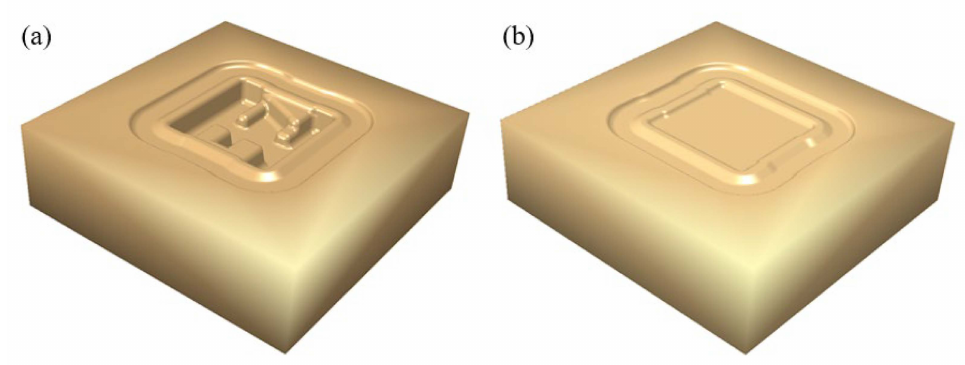
Figure 3. The designed structure of dies: ( a ) top die and ( b ) bottom die.